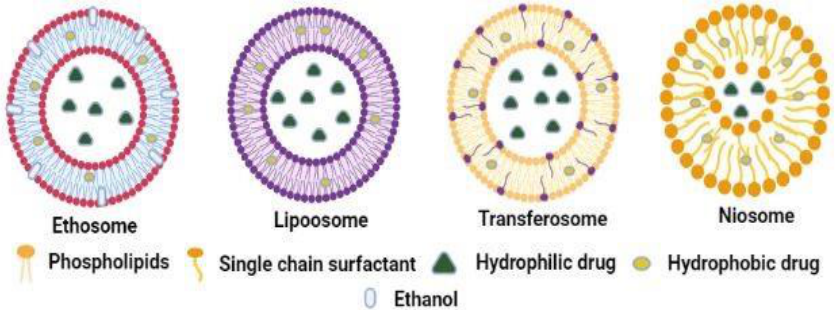
Figure 5. Structure of ethosome, liposome, transferosome, and niosome. Liposomes are composed of phospholipids and cholesterol and have one or more bilayer structures. Phospholipids are the key components of liposomes and are am- phiphilic as they comprise both polar heads and non-polar tails. Owing to these features, liposomes can encapsulate both lipophilic and hydrophilic drugs [39]. A lipophilic drug is encapsulated between the lipid bilayer of the liposomes, whereas a hydrophilic drug is encapsulated in the liposome core. Liposomes disrupt the outer layer of the SC, in which the phospholipid components act as permeation enhancers that assist drug penetration into the skin. Liposomal-based transdermal drug delivery has been used for numerous drugs. Examples of drugs include diclofenac, ketoprofen, baicalein, vitamin C, amphoter- icin B, and azithromycin [40 – 45]. Ethosomes are the second type of nanovesicles employed to enhance transdermal drug delivery. Phospholipids and alcohol (20 – 40%), such as eth- anol, are the main components of the ethosome. The main objectives behind using ethanol are to improve the flexibility of conventional liposomes and to act as a skin penetration enhancer for a drug. Due to improved biocompatibility and enhanced drug permeability, it is considered a superior technique than liposomes [46]. Numerous drugs, such as cur- cumin, valsartan, indomethacin, quercetin, mitoxantrone, econazole nitrate, apigenin, and green tea extract, are delivered through the skin membrane by using ethosomes as a car- rier system [47 – 54]. Transdermal absorption of drugs can be improved by ethosomes, which are nanocar- riers with exceptional deformability and drug-loading capacity. Ethanol within the ethosomes increases the membrane fluidity and permeability of the phospholipid, leading to drug leakage. To address this issue, a new phospholipid nanovesicle containing ethanol co-hybridized with hyaluronic acid (HA) was developed, and volatile oil medicines (eu- genol and cinnamaldehyde [EUG/CAH]) were encapsulated for transdermal administra- tion. The results suggested that in contrast with EUG/CAH-loaded ethosomes (ES), the stability and transdermal absorption of EUG/CAH-loaded HA-immobilized ethosomes (HA-ES) were significantly enhanced [55]. Transethosome, a modified version of